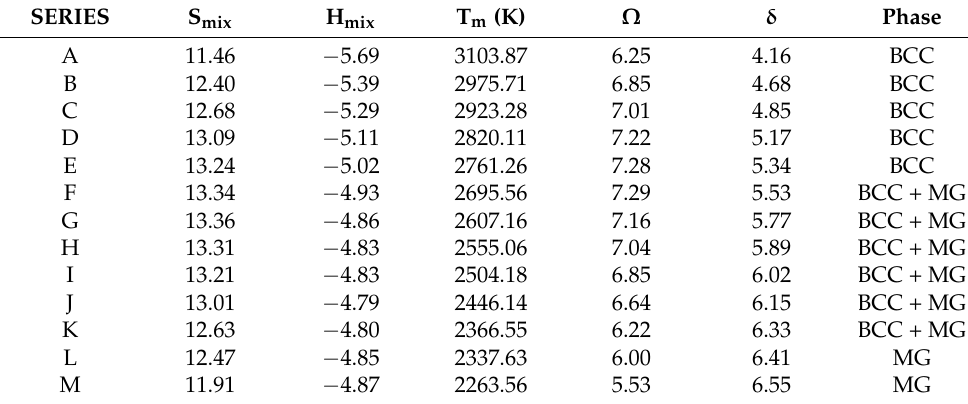
Table 2. Thermodynamic-parameter calculations and phase-structure predictions of the (TiCrV)x- (TaW)1-x (A-M) binary system HEA film.